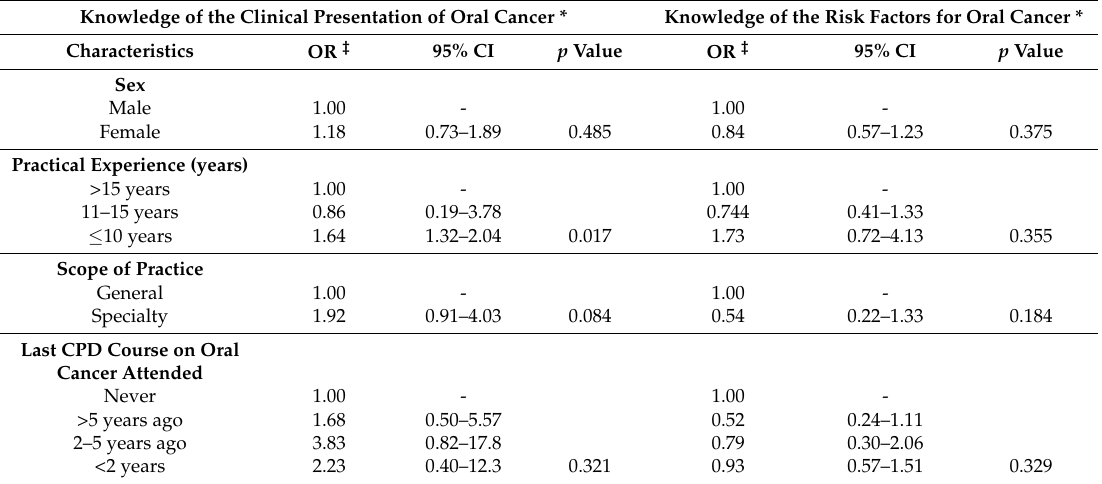
Table 4. Univariate logistic analysis of the likelihood of having a satisfactory knowledge of oral cancer ( n = 177). Knowledge of the Clinical Presentation of Oral Cancer * Knowledge of the Risk Factors for Oral Cancer